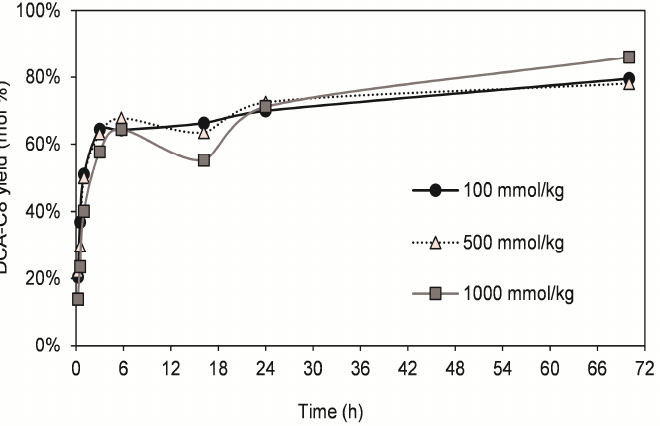
Figure 5. Time-course of DCA-C8 yield in reactions at different equimolar concentrations of DCA and octanoic acid. Reaction conditions: solvent ( tert -butanol), lipase 1% (w/w solvent), molecular sieves (1.5× in excess), 60 °C. Table 1. DCA-C8 yields in different reactions with an excess of octanoic acid, both in solvent and solvent-free conditions. The C8/DCA values displayed correspond to the molar ratio between the two